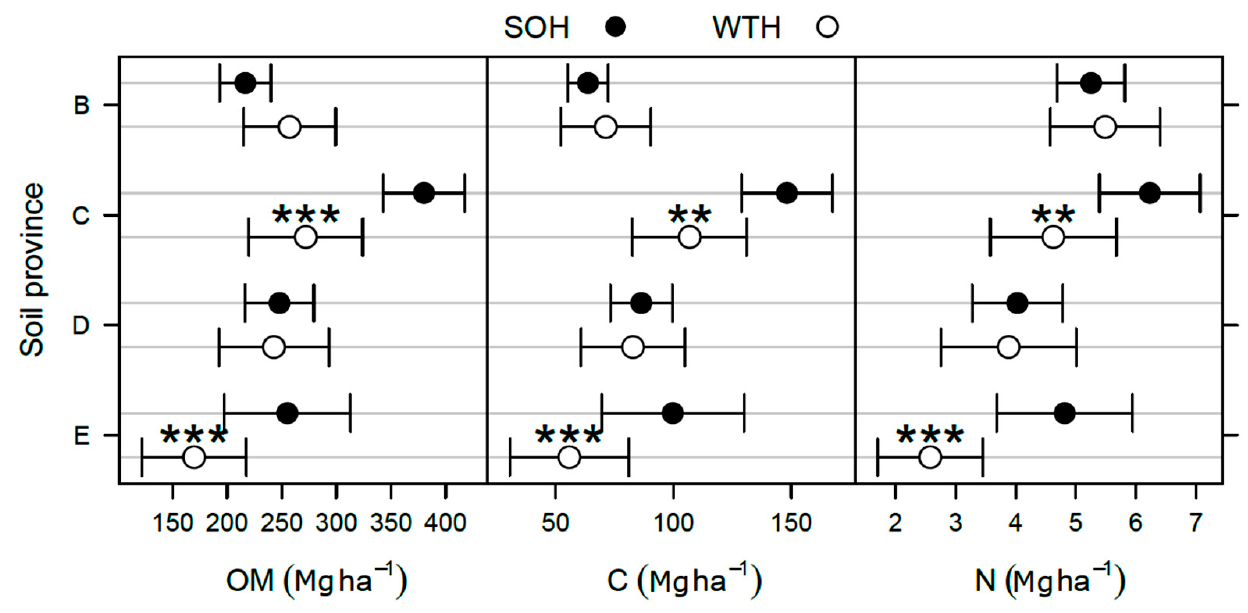
Figure 3. Organic matter (OM), organic total carbon (C), and total nitrogen (N) pools in the first 60 cm of soil (forest floor excluded) as a function of harvesting treatment (stem-only harvesting (SOH) and whole-tree harvesting (WTH)) in four soil provinces of Quebec: B = Appalachians; C = Laurentians; D = Abitibi Lowlands; E = Mistassini Highlands. Data presented are model-adjusted means ± 95% confidence intervals. Asterisks indicate significant differences between harvesting treatments within a given soil province: * p ≤ 0.05, ** p ≤ 0.01, *** p ≤ 0.001.